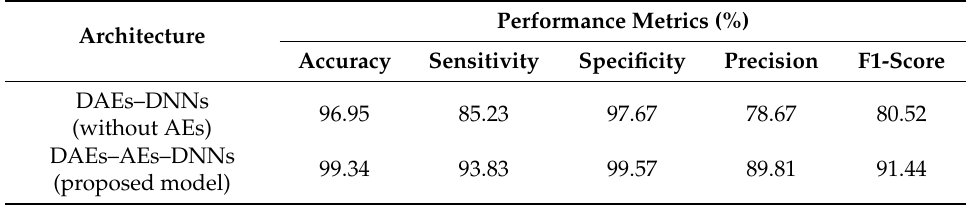
Table 7. The comparison results of DAEs–AEs–DNNs and